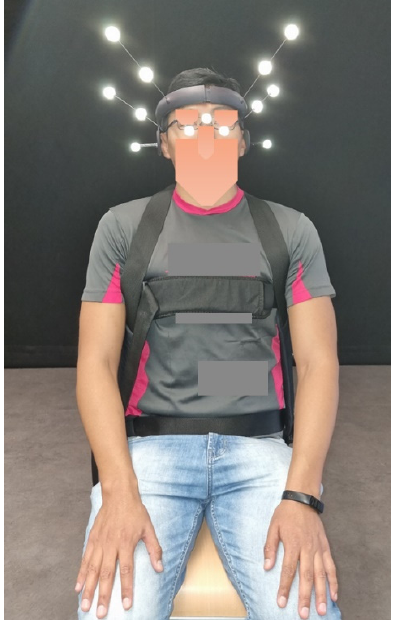
Figure 1. Experimental setup.